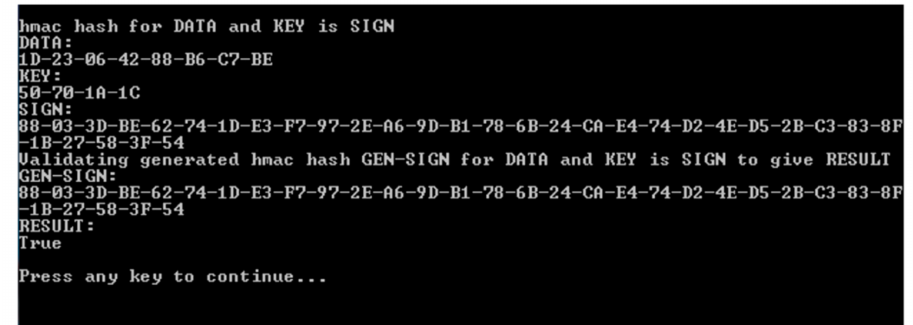
Figure 13. REGUS validating data from the solar panel for a specific data packet.